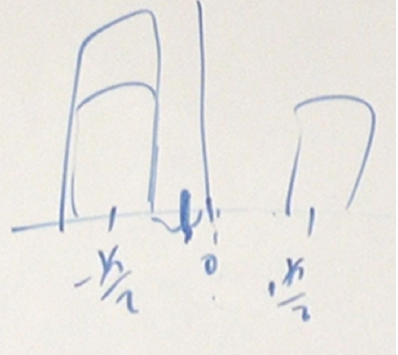
FIG. 4. Raife ’ s depiction of a histogram for spin. He identifies that an equal probability will yield an expectation value of 0 and a higher probability of − ℏ = 2 will mean the expectation value will be shifted to the left (thick vertical